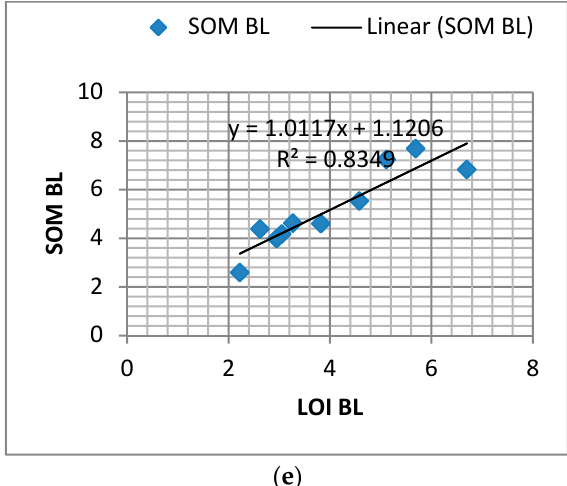
Figure 3. Relationship between loss on ignition (LOI) and soil organic matter (SOM) in different land use types ( a ) cultivated land ( b ) grassland ( c ) forest land ( d ) bush land and ( e ) bare land.